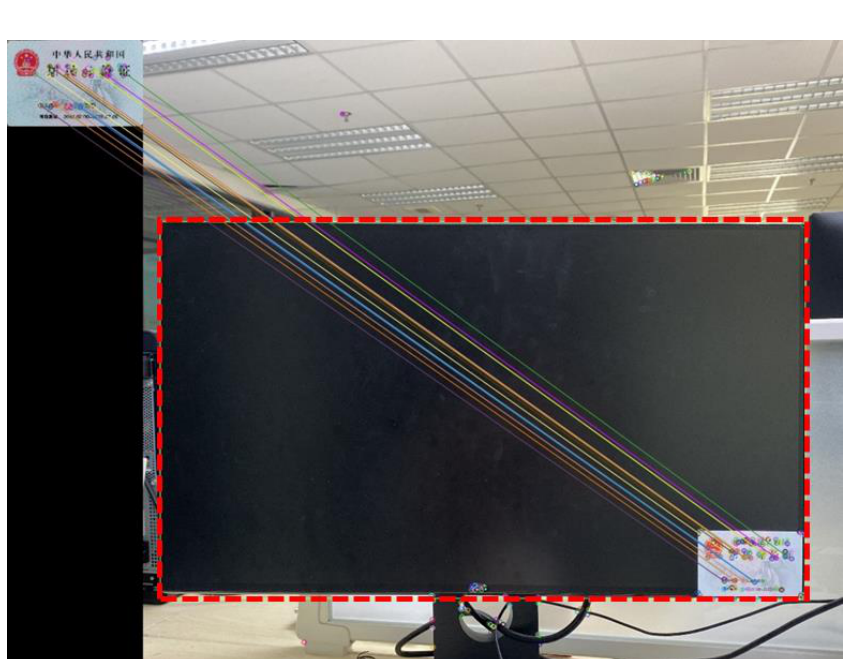
Table 5. The vision-based measurement results with SR-SYBA.